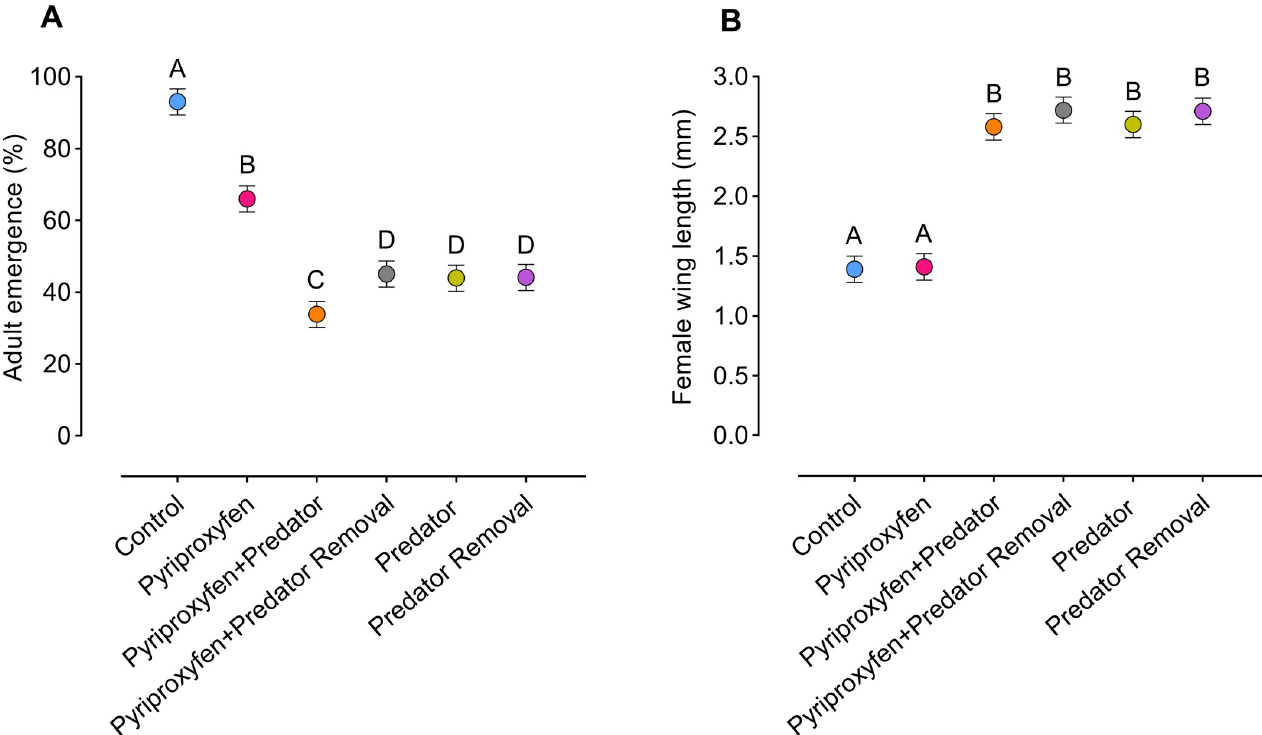
Fig 3. Effects of juvenile treatments on Ae . aegypti traits. (A) Adult emergence and (B) female wing length (an indicator of body size). Dots represent the means. Whiskers denote the standard error of the means. Statistical significance was determined by ANOVA. Different letters indicate significant differences ( p < 0.05) between juvenile treatment